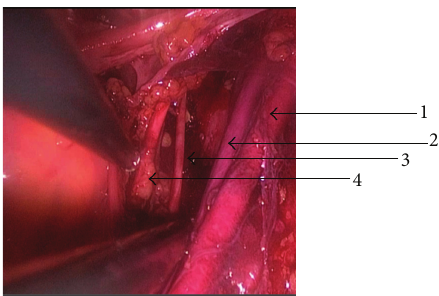
Figure 3: External iliac artery (1), external iliac vein (2), obturator nerve (3), and ureter (4) at the end of right pelvic lymphadenectomy.